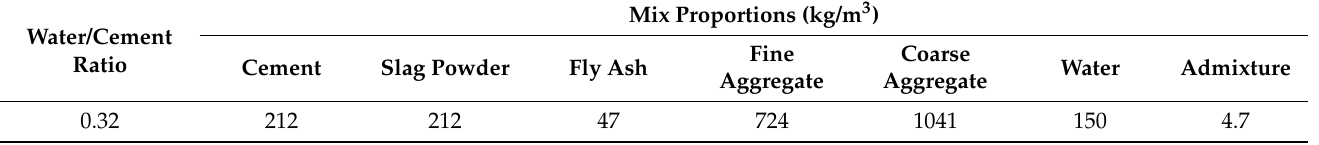
Table 1. Mix proportions of